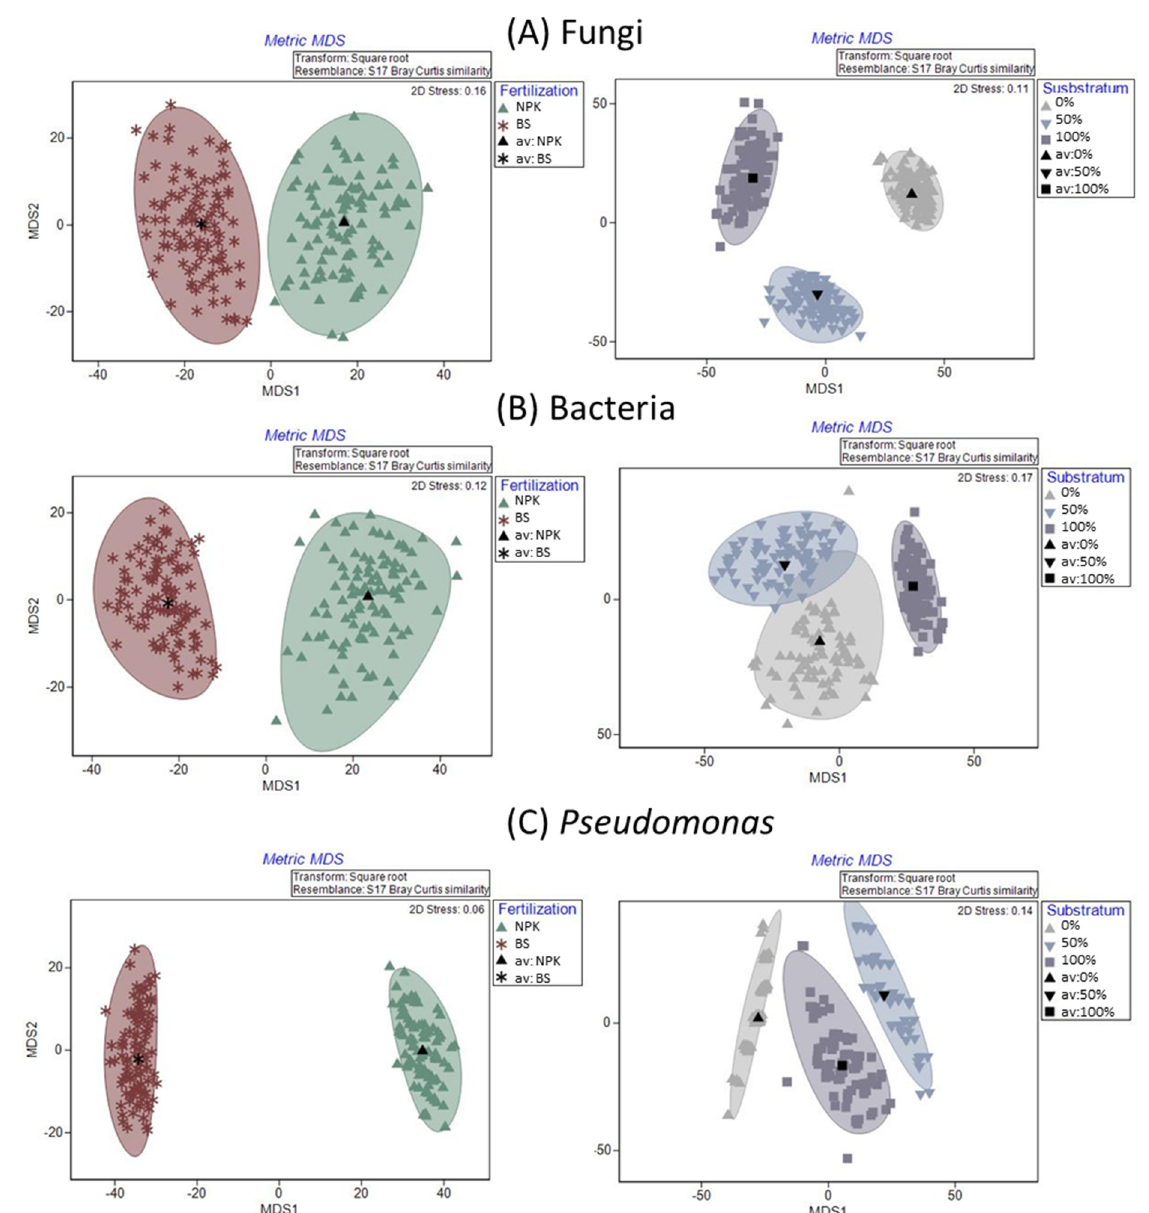
Figure 7. Multidimensional scaling (MDS) using bootstrap averages of the different biota communities (( A ) Fungi, ( B ) Bacteria, ( C ) Pseudomonas ) based on Bray–Curtis index. Metric MDS ordination employed (100 per group) bootstrap averages of the centroid of each sample to show where 95% of the centroid averages lay within multivariate space. Figures on the left represent cultures compared regarding fertilization: NPK (green) vs. BS (brown). Figures on the right represent cultures compared regarding substrate composition: 0% (grey), 50% (light purple) and 100% (dark purple).